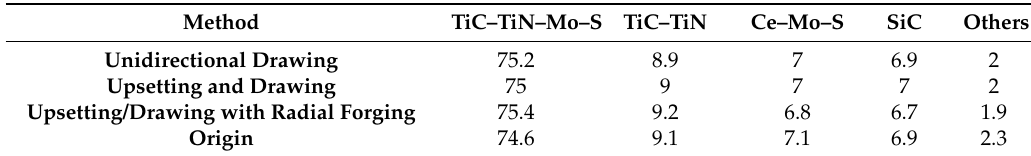
Figure 4. SEM images and EDS mapping of other inclusions: ( a ) Al 2 O 3 ; ( b ) MgO; and ( c ) Ti–Mo–Zr–C–S. Table 2. Proportions of various types of inclusions for three hot working and origin methods (%)